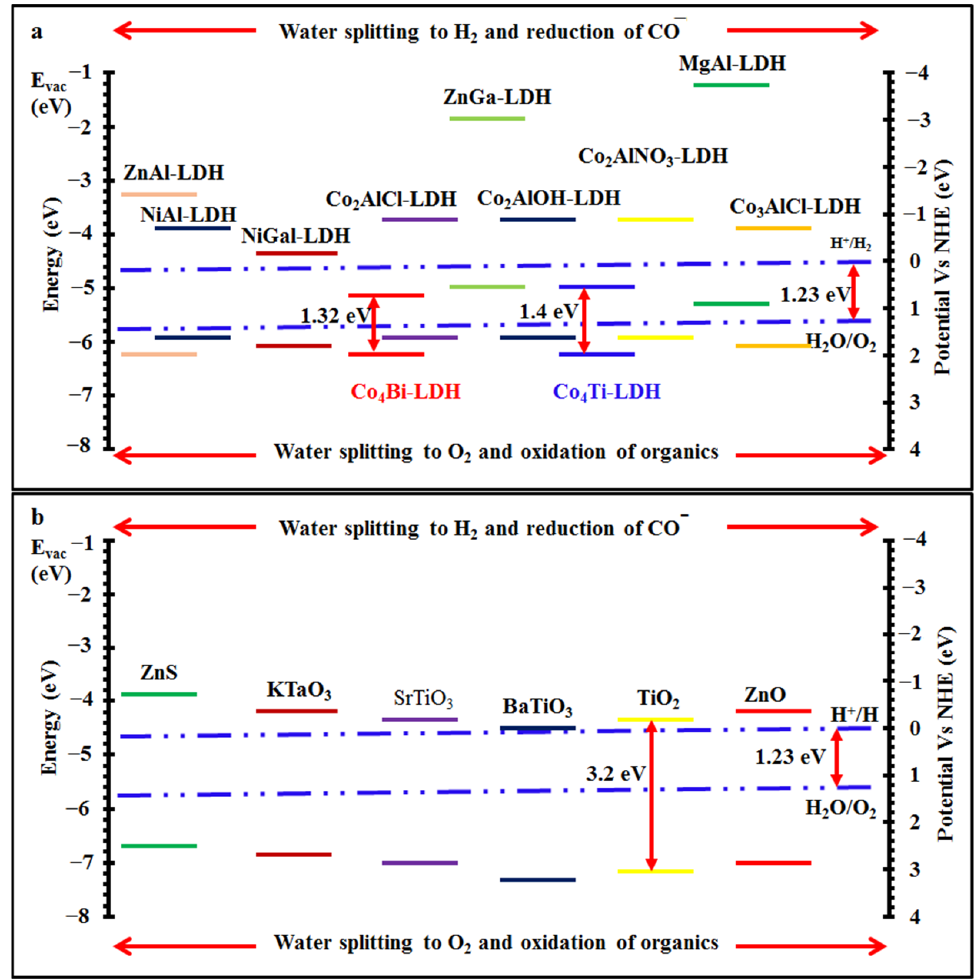
Figure 12. The CB/VB potentials of common LDHs ( a ) compared to those of conventional metal oxide photocatalysts ( b ); it is obvious how the LDH-structure can greatly improve the photocatalytic properties and lower the bandgap energies.